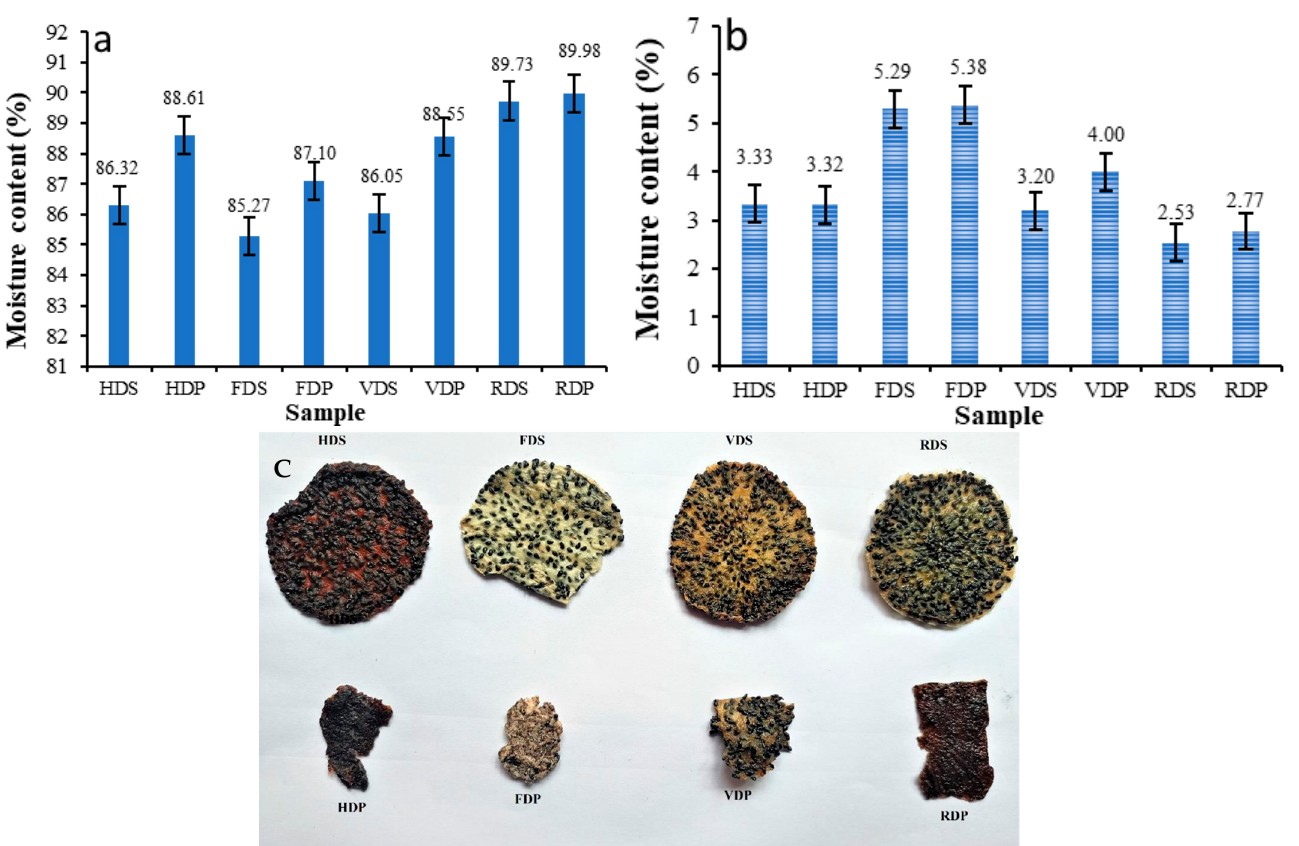
Figure 2. Moisture content of ( a ) dragon fruit sample and ( b ) dried sample powder, and ( c ) the dried products. HDS, hot air oven-dried dragon fruit slice; HDP, hot air oven-dried dragon fruit pulp; FDS, freeze-dried dragon fruit slice; FDP, freeze-dried dragon fruit pulp; VDS, vacuum-dried dragon fruit slice; VDP, vacuum-dried dragon fruit pulp; RDS, RW-dried dragon fruit slice; RDP, RW-dried dragon fruit pulp.